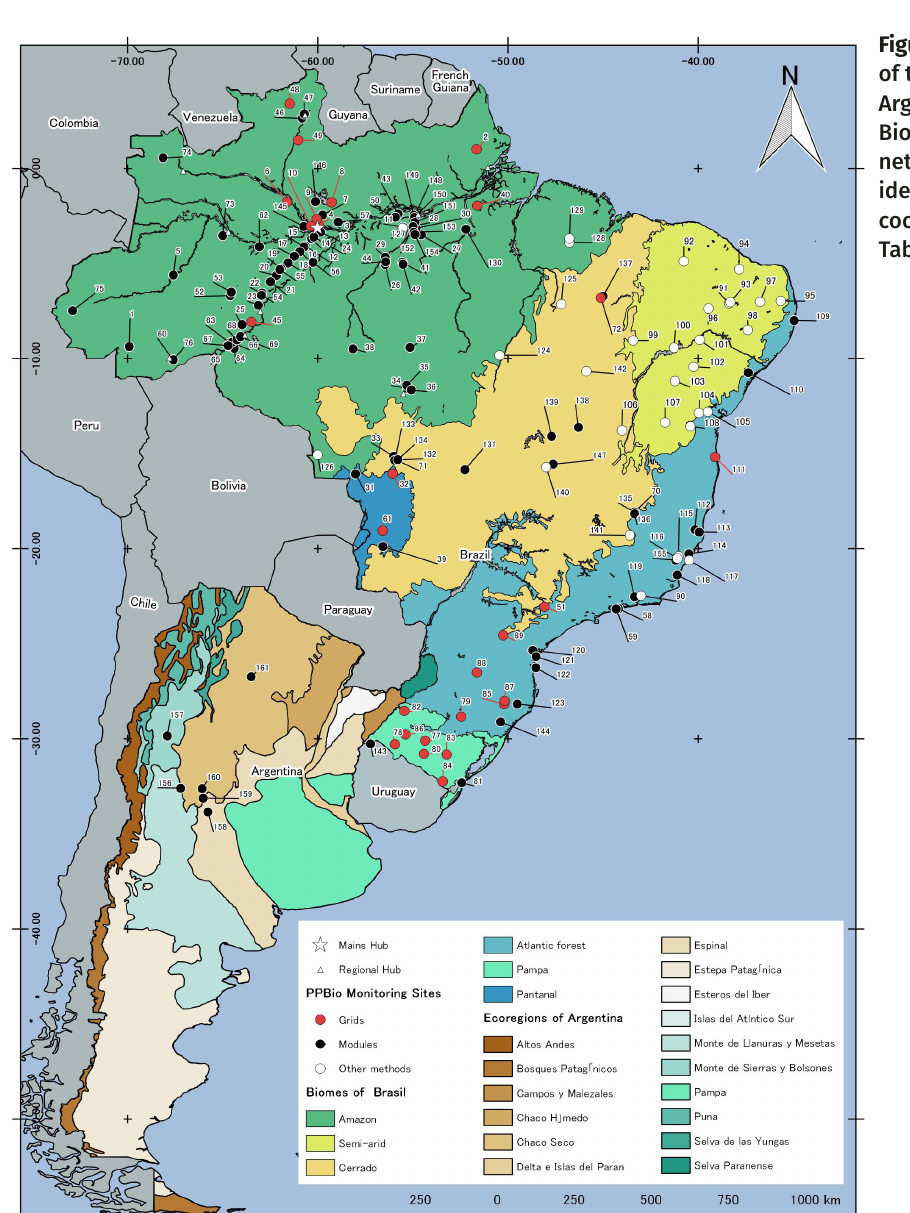
Figure 1. Sampling sites of the Brazilian and the Argentine Program for Biodiversity Research networks. See the identification and coordinates of each site